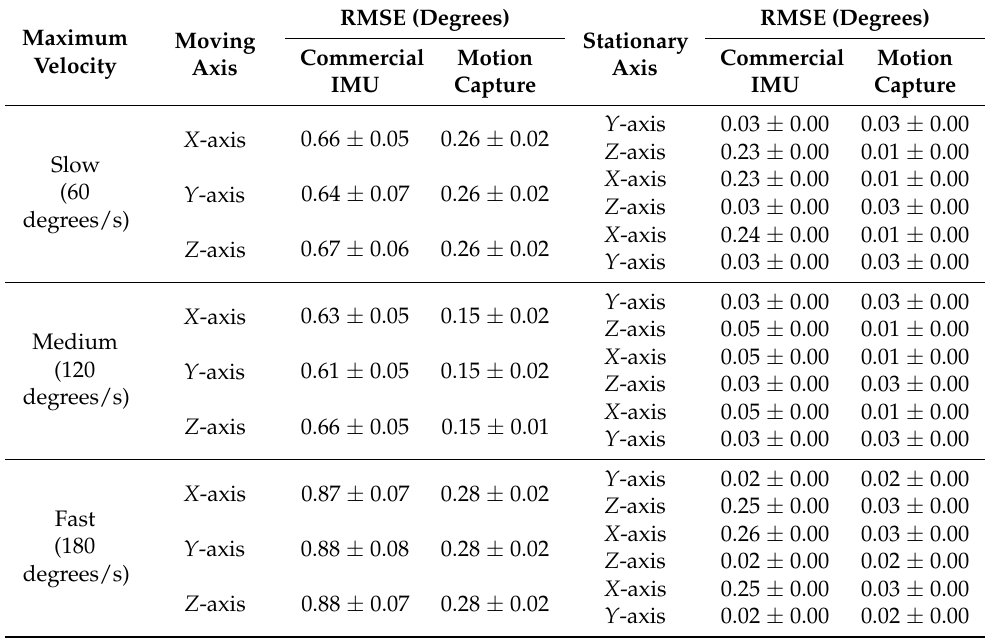
Table 2. Accuracy and repeatability results for the Gaussian movement profile. Shown is the root- mean-square error (RMSE) for the three different movement axes and three different movement velocities: 60 degrees/s, 120 degrees/s, and 180 degrees/s.